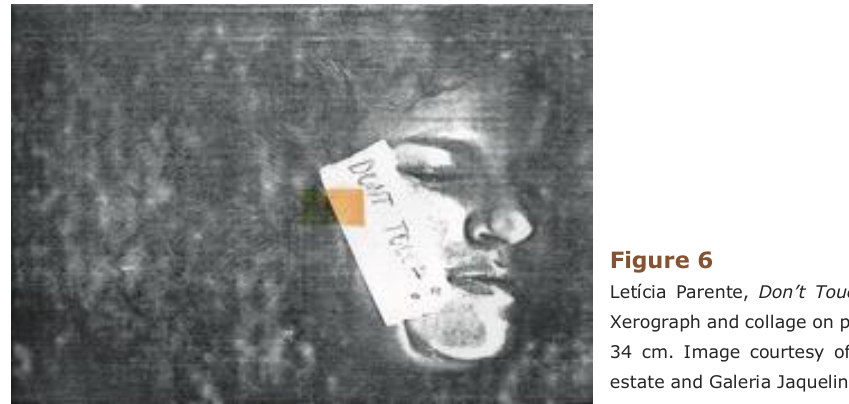
Letícia Parente, Don’t Touch Me , n.d., Xerograph and collage on paper, 21.5 x 34 cm. Image courtesy of the artist’s estate and Galeria Jaqueline